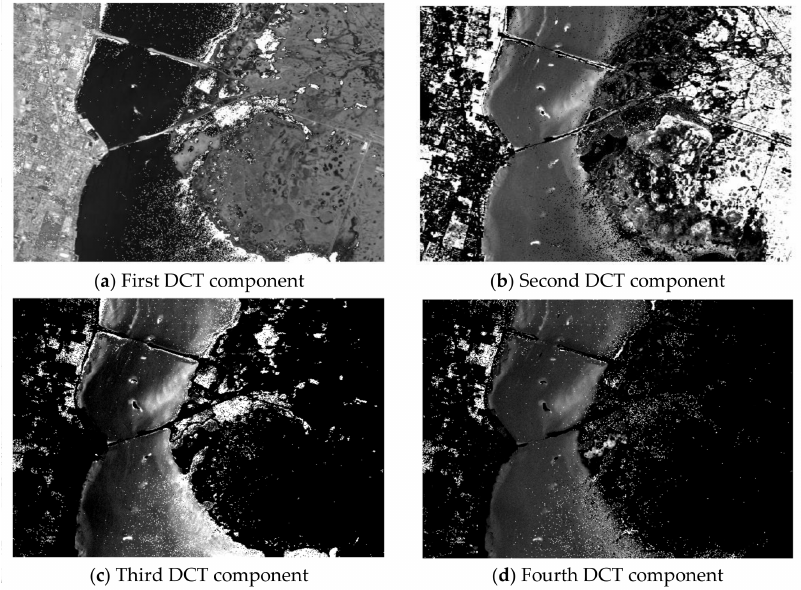
Figure 2. The first four transformed components of the spectral-DCT feature space from the Kennedy Space Center